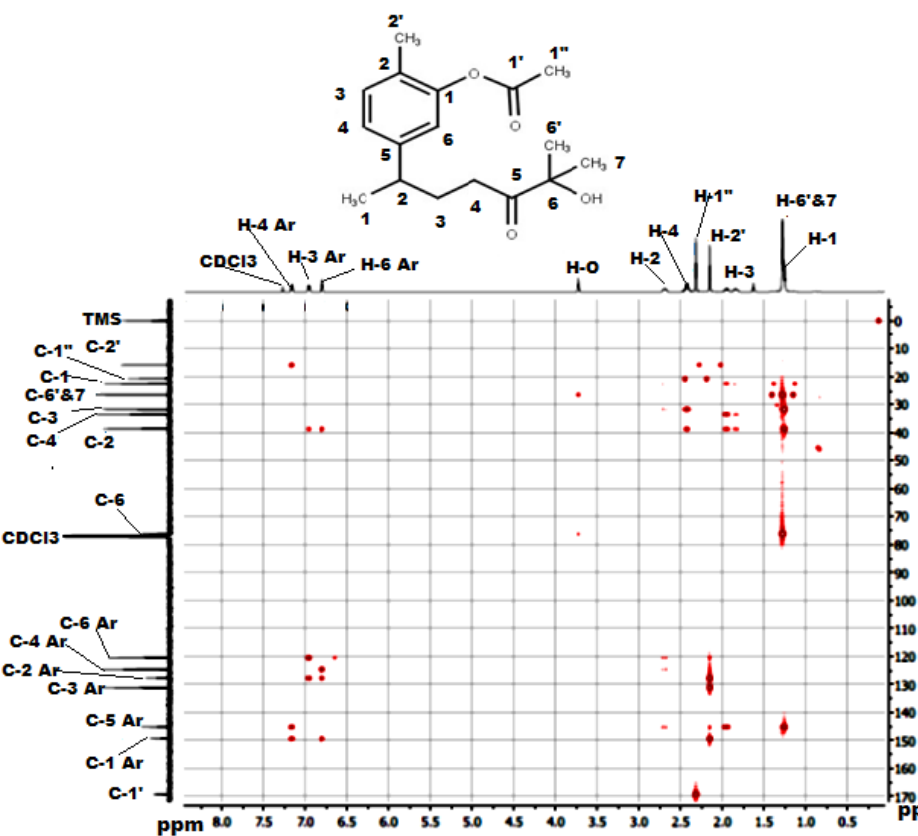
Figure 1. Two-dimensional (2D)-Heteronuclear Multiple Bond Correlation (HMBC) spectrum of the title compound 2 . Table 1. HMBC Correlations for the title compound 2 .